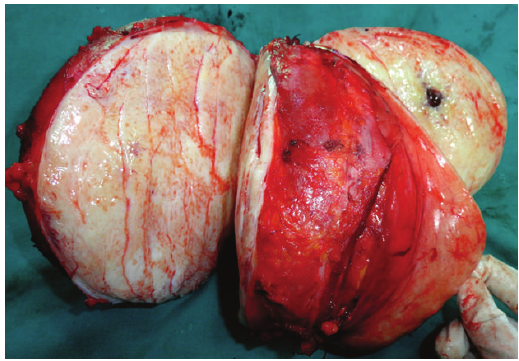
Figure 5: Image showing reconstruction of defect with mesh.